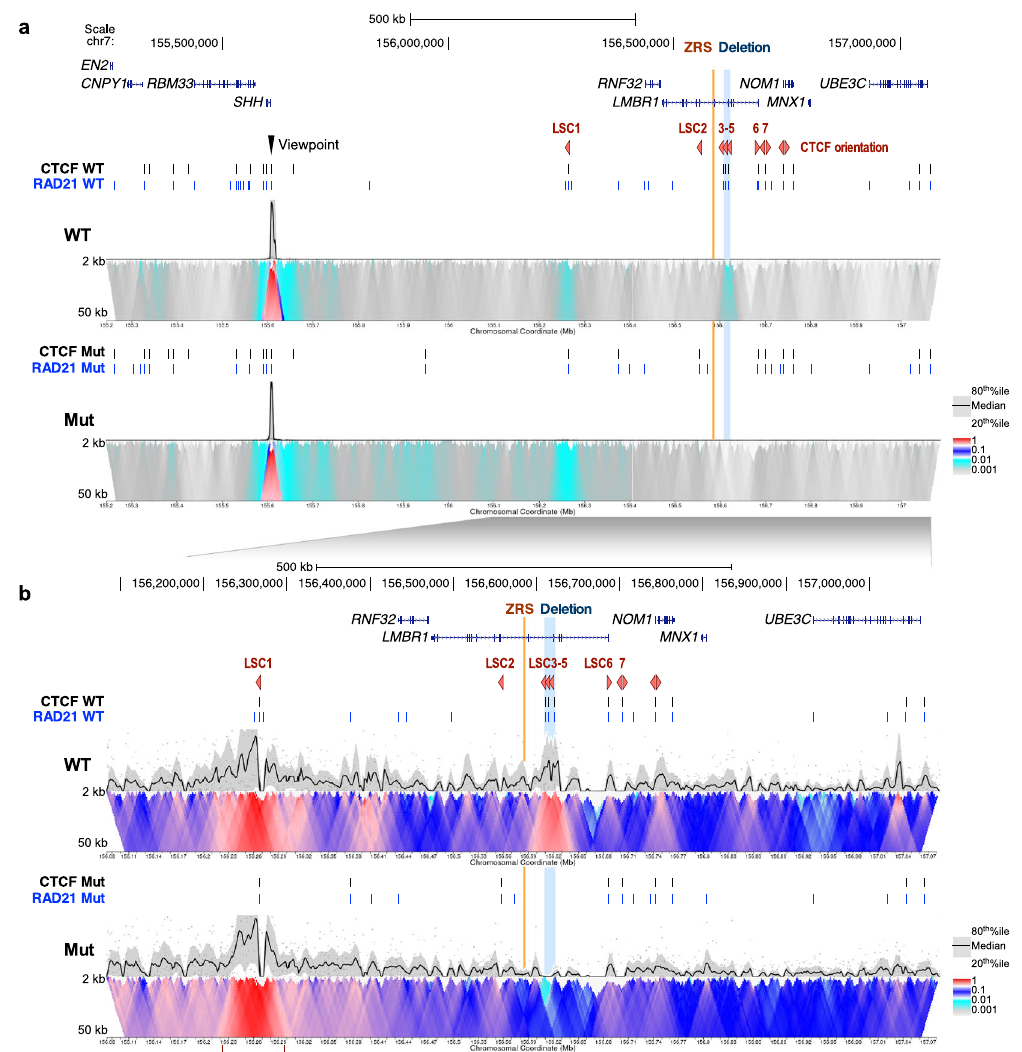
Fig. 4 Chromatin interactions with the SHH promoter. a 4C contact pro fi les in lymphoblastoid cells from wildtype (WT) and proband (Mut) at the LMBR1 - SHH locus. The viewpoint is depicted by a black arrowhead. The median and 20th and 80th percentiles of sliding 2 – 50 kb windows determine the main trend line. The color scale represents enrichment relative to the maximum medium value attainable at 12 kb resolution. CTCF and RAD21 ChIP-seq peaks are shown as black and blue vertical line respectively. The ZRS and the acheiropodia-associated deleted region are shown as orange and blue vertical lines respectively. CTCF orientations are shown as red triangles. b Zoom in of the region around the LMBR1